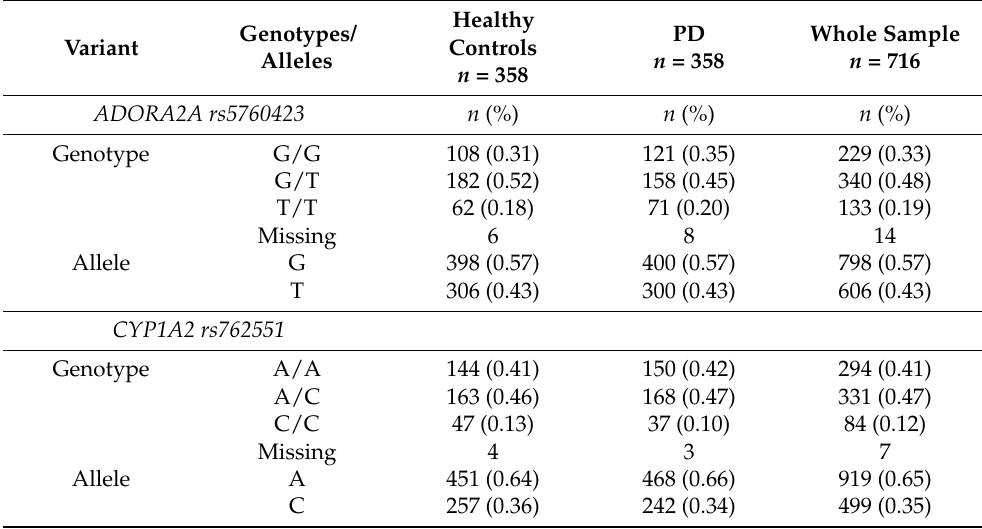
Table 2. Allelic and genotype frequencies for ADORA2A rs5760423 and CYP1A2 rs762551 in healthy controls, in PD cases and whole sample.